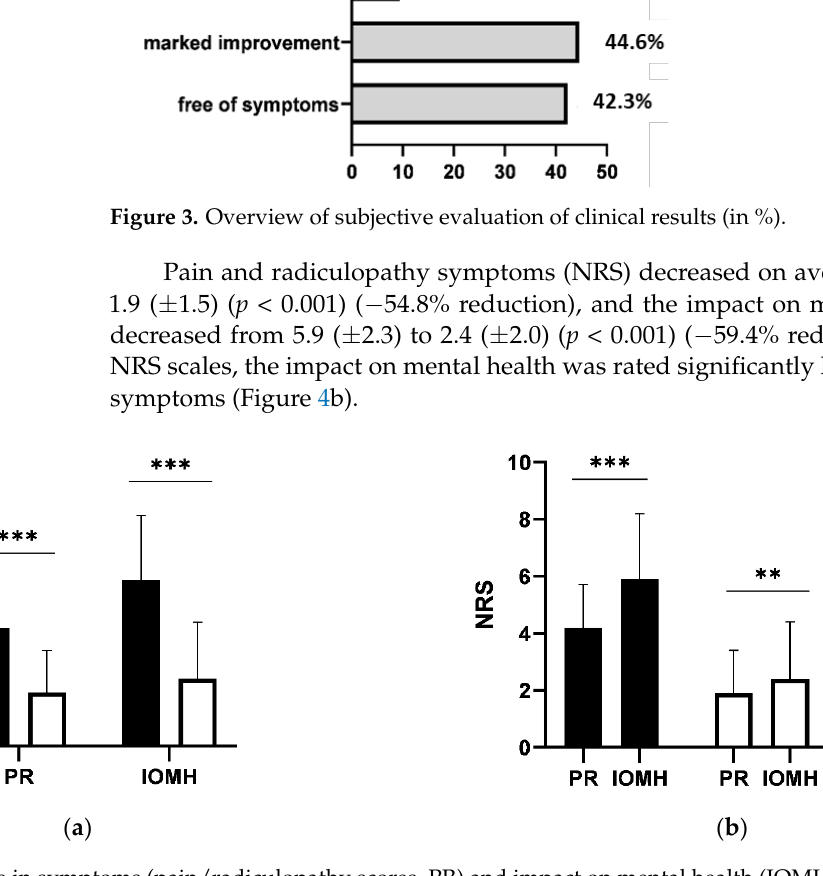
Figure 4. Change in symptoms (pain/radiculopathy scores, PR) and impact on mental health (IOMH) before and after the rehabilitation program ( a ). Comparison between PR and IOMH before and after the study ( b ). (** p < 0.01, *** p < 0.001)